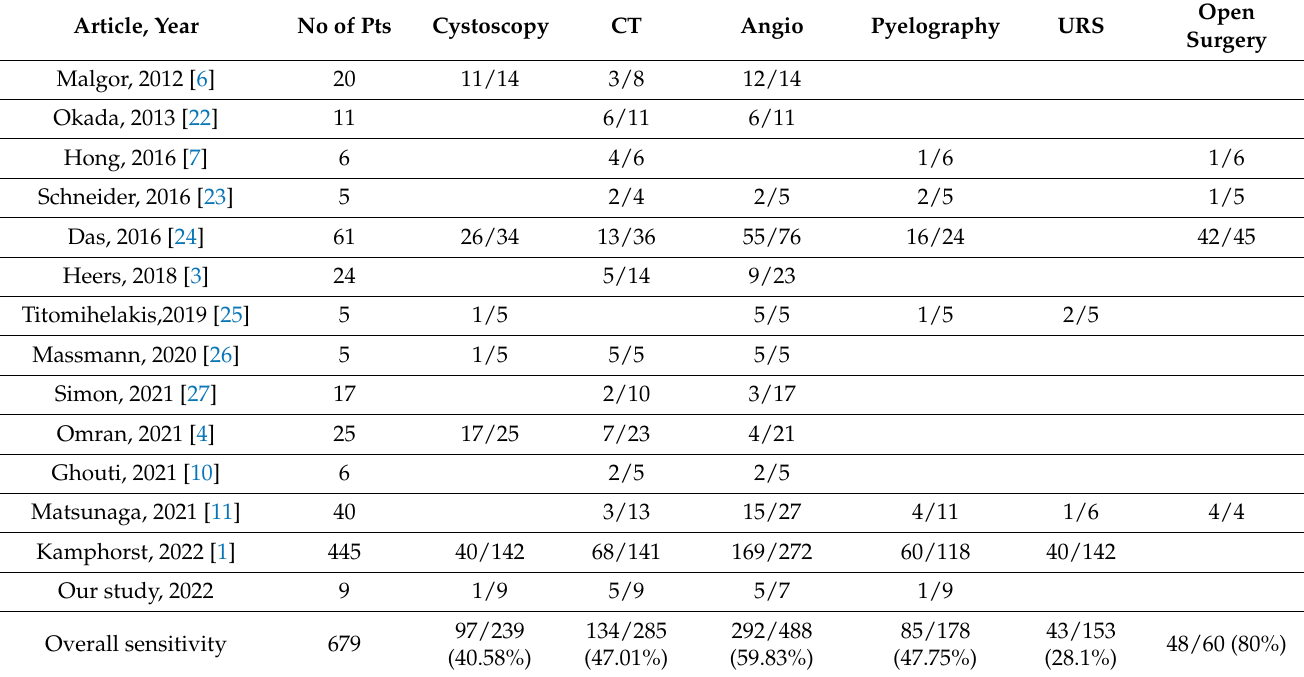
Table 4. Diagnostic test sensitivity of different imaging procedures used for diagnosis of UAF (pts—patients, CT—computed tomography, angio—angiography,